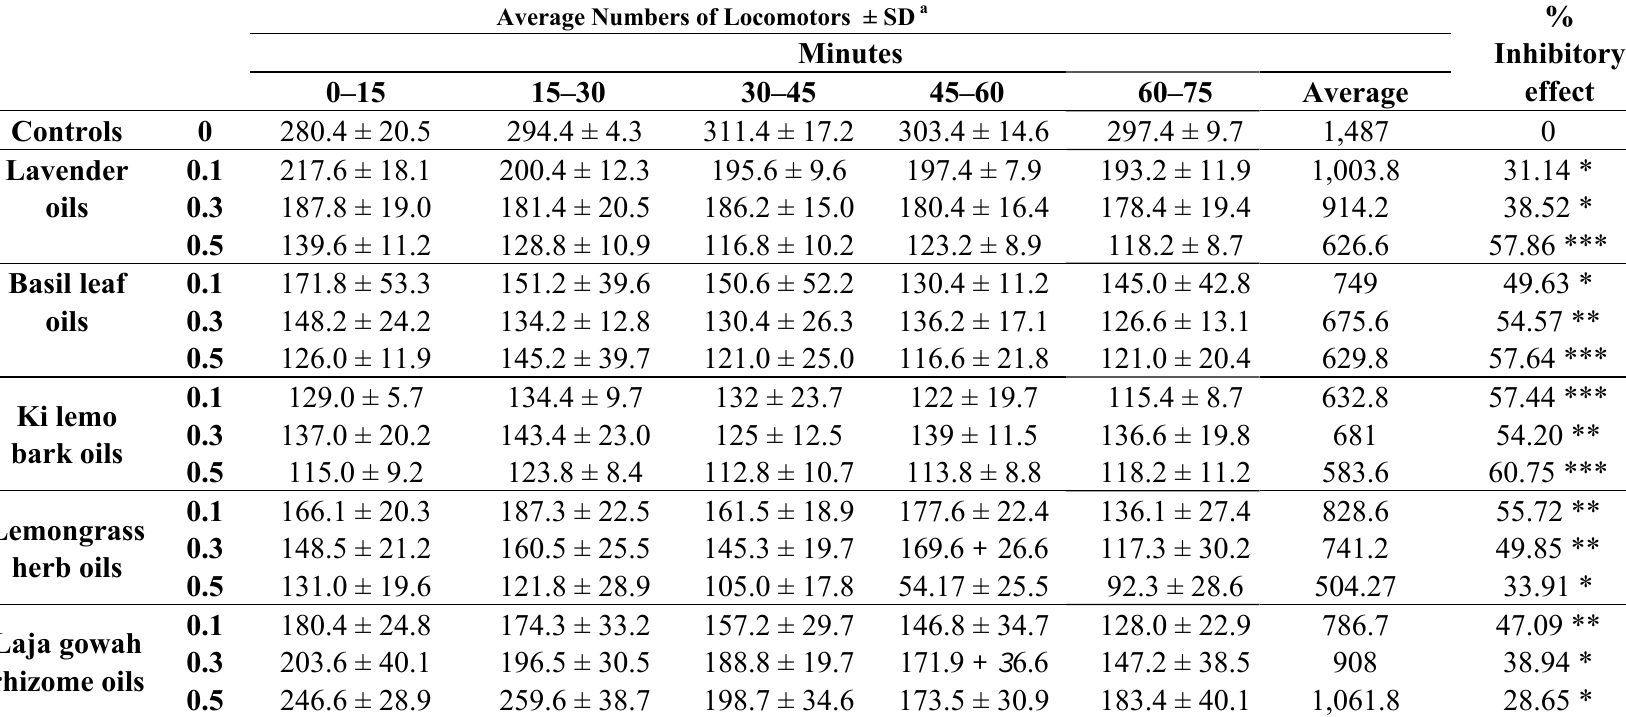
Table 1. Average number of mice wheel cage rotations within 75 min of inhalation of essential